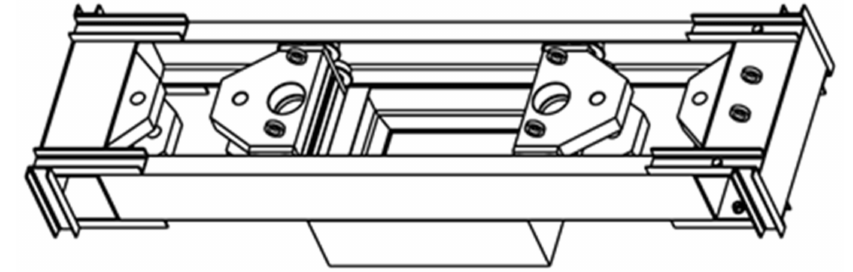
Figure 6. Fixation table of the test equipment